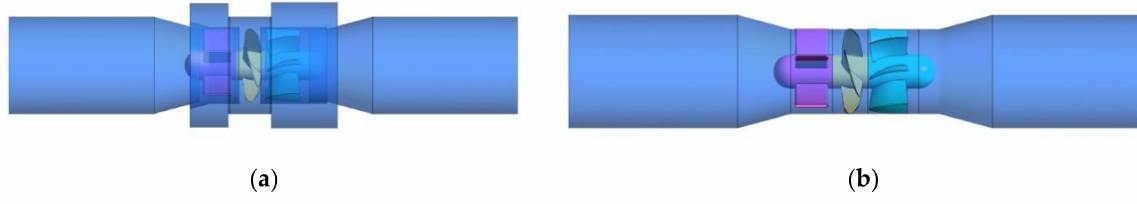
Figure 8. Computational model. ( a ) The full tubular pump, ( b ) The axial flow